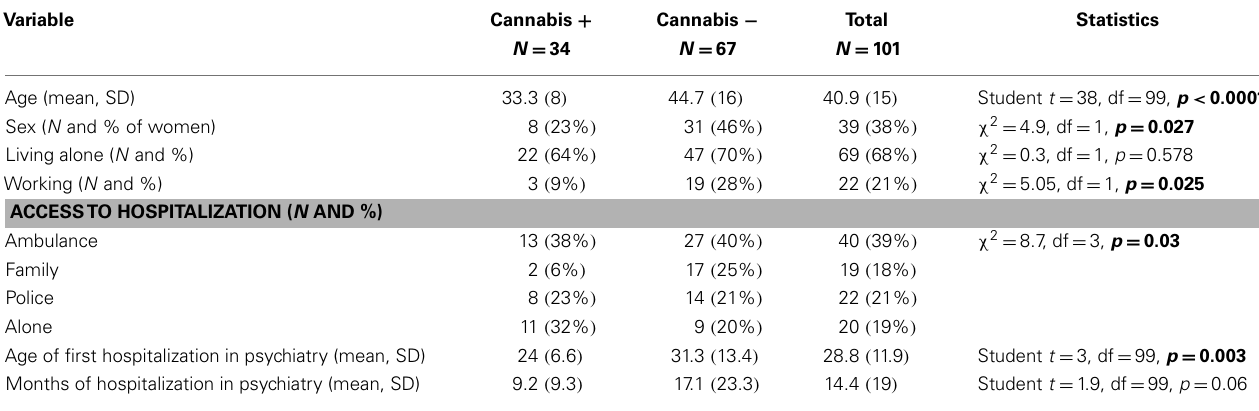
Table 1 | Comparison of schizophrenic patients with and without cannabis consumption: socio-demographic characteristics, access to hospitalization, and duration of hospitalization